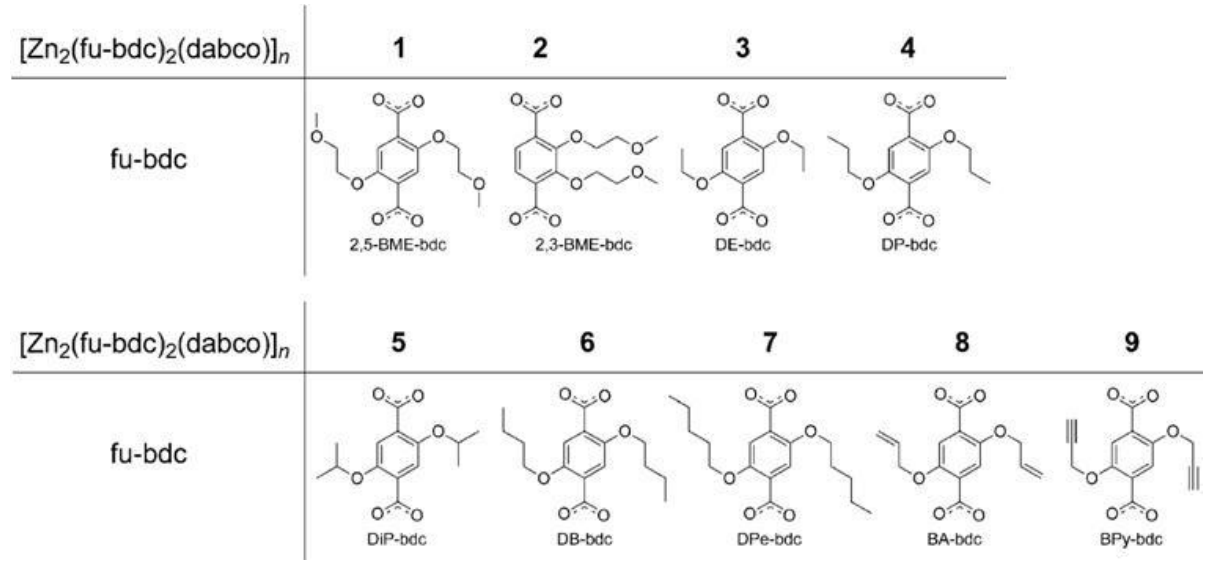
Figure 26. Chemical structure of derivatives of 2,3-dihydroxyl-BDC and 2,5-dihydroxyl-BDC. Reprinted with permission from [76]. Copyright 2012 American Chemical Society.